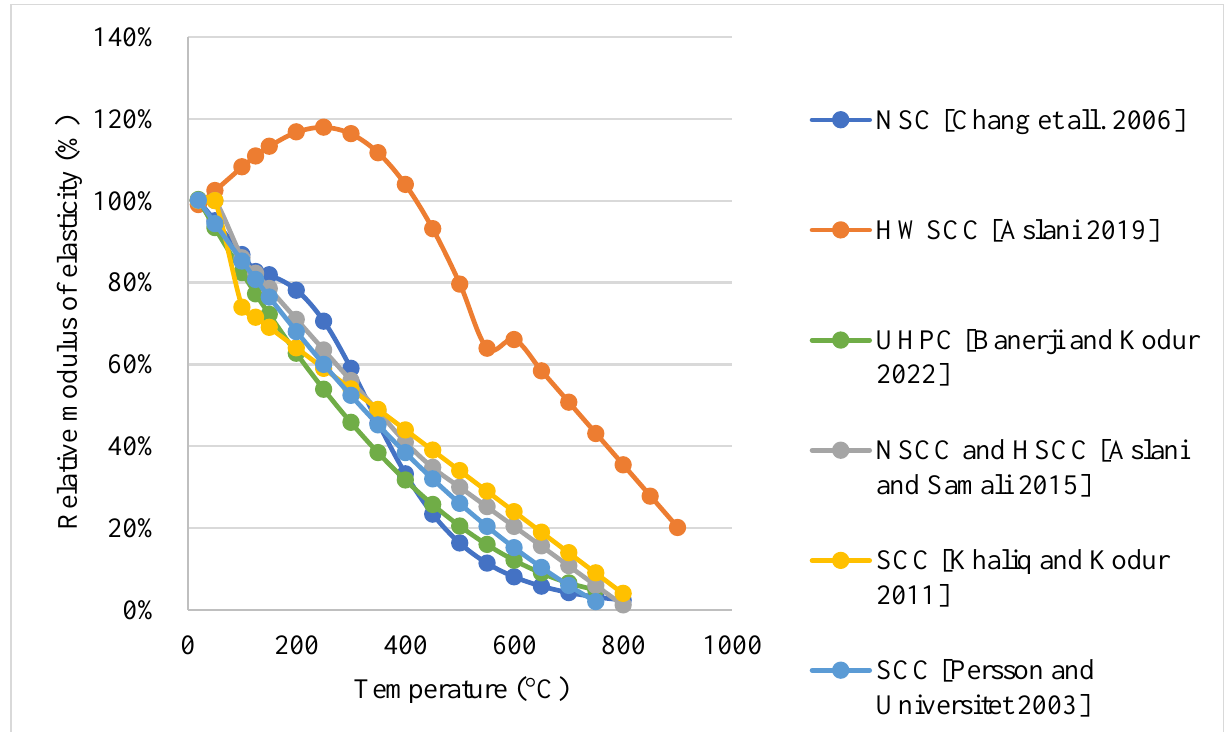
Figure 50. Relative tensile strength models for different types of concrete 2 [100].